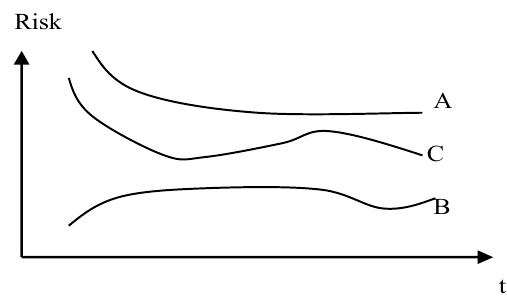
Figure 2. Dynamics of aggregate risk by sectors in the portfolio of the economic system.